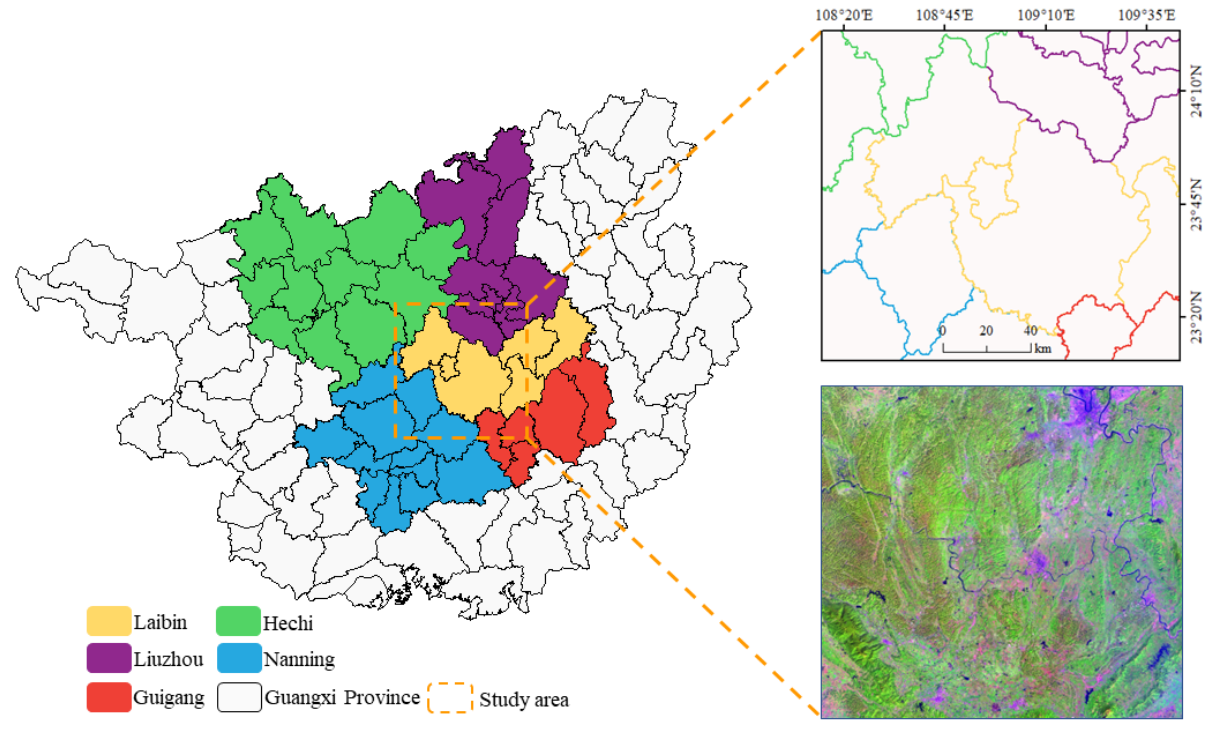
Figure 1. Schematic diagram of the study